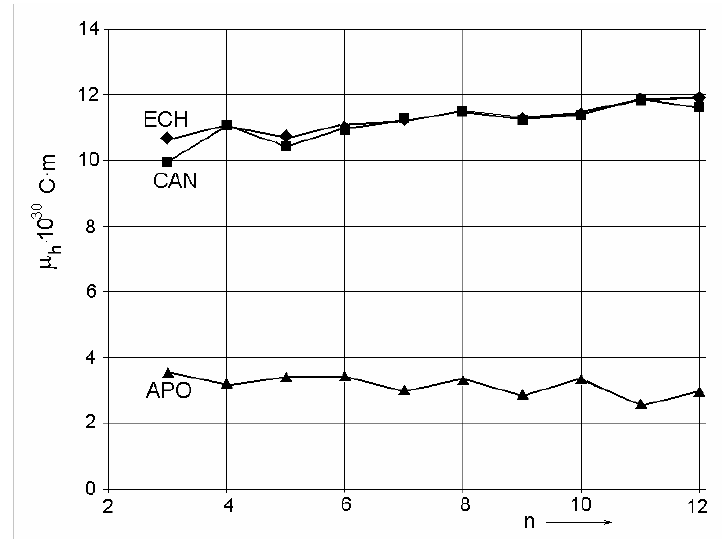
Fig. 5 Horizontal component of the dipolmoment μ h versus number n of conjugated bonds (PM3 calculation).